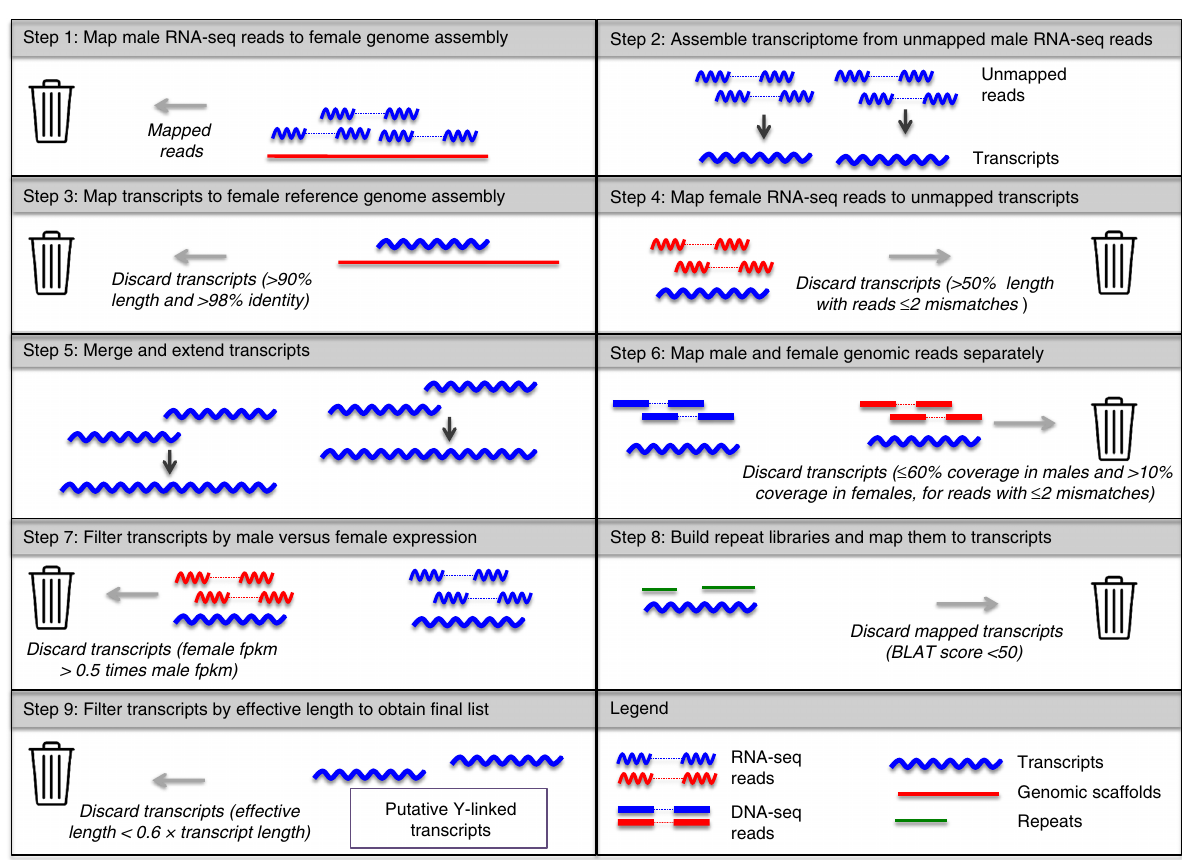
Fig. 1 Bioinformatic subtraction pipeline to infer Y-linked transcripts. Male RNA-seq reads are mapped to genomic scaffolds build from female genomic reads (Step 1); unmapped male RNA-seq reads are used to build a de novo transcriptome (Step 2), and transcripts that either map to the female genome assembly (Step 3) or female RNA-seq reads (Step 4) are discarded. Remaining transcripts are merged (Step 5) and only merged transcripts are kept that show mapping to male genomic reads and no mapping to female genomic reads (Step 6) and that show expression in males but not females (Step 7). Transcripts that mapped to a de novo repeat library were discarded (Step 8), and only transcripts which had an effective length (as calculated by the software eXpress) greater than 0.6 times the transcript length were kept in the fi nal list (Step